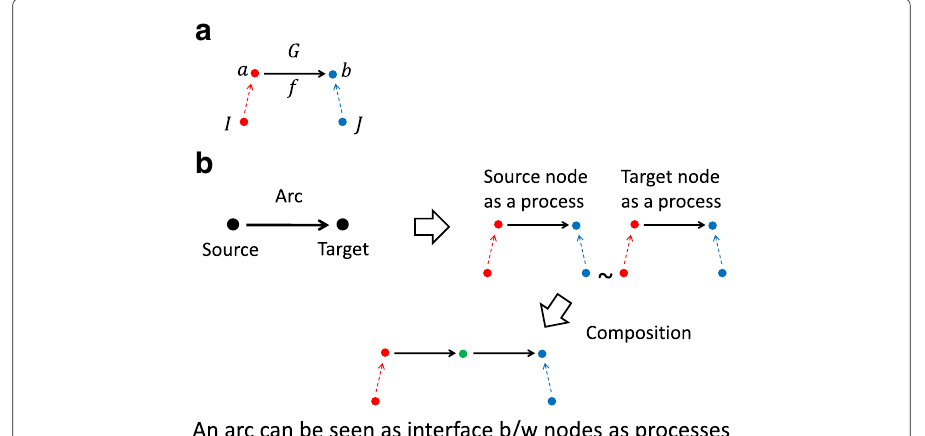
Fig. 2 a A cospan representing nodes as processes. b What happens when two nodes as processes are linked by an